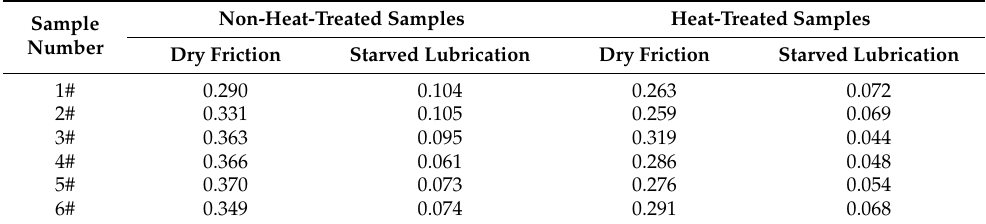
Figure 10. Friction coefficient curve of each heat-treated sample under the starved lubrication condition. Table 5. Average friction coefficient of all samples.